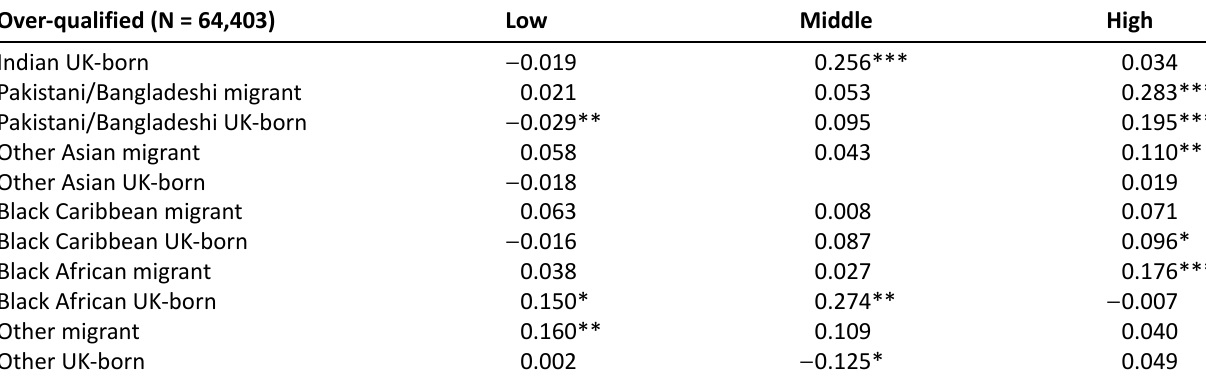
Table A9. Robustness tests for women: Binary logistic regression of being employed rather than unemployed, and under- and over-qualification using